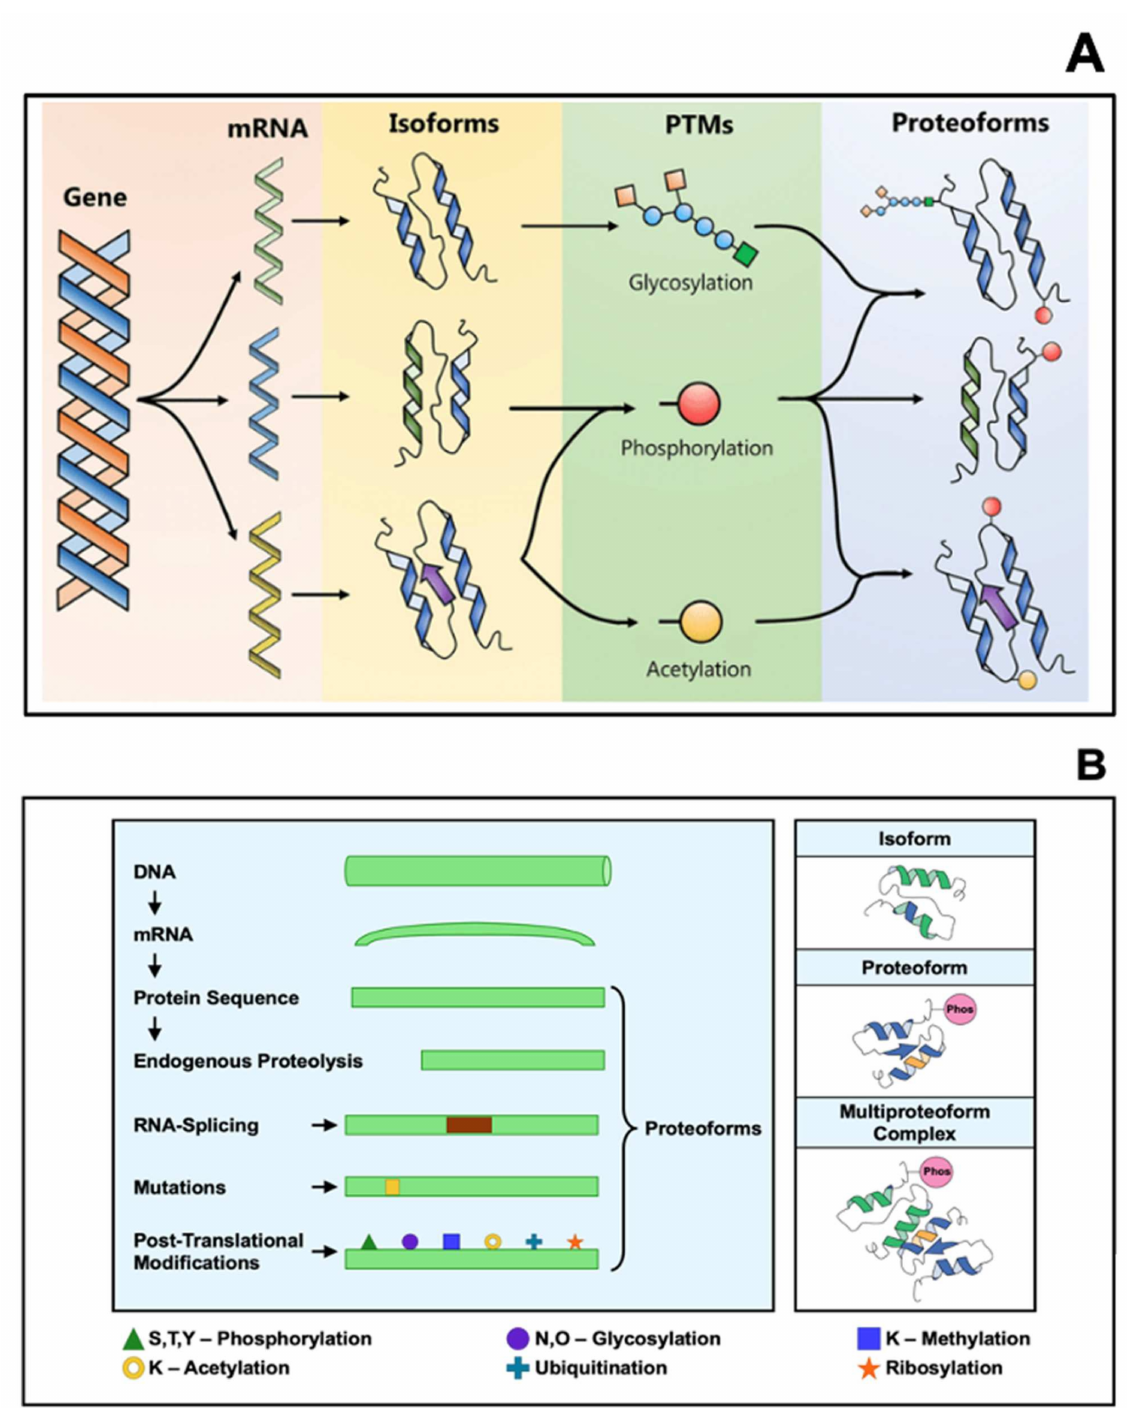
Figure 2. Schematic representation of ( A ) a single gene and three isoforms; the isoform variations combine with site-specific changes to generate proteoforms via post-translational modifications (PTMs). ( B ) Schematic depicting various types of isoforms, including individual examples of an isoform, a proteoform, and a multiproteoform complex. Figures modified from